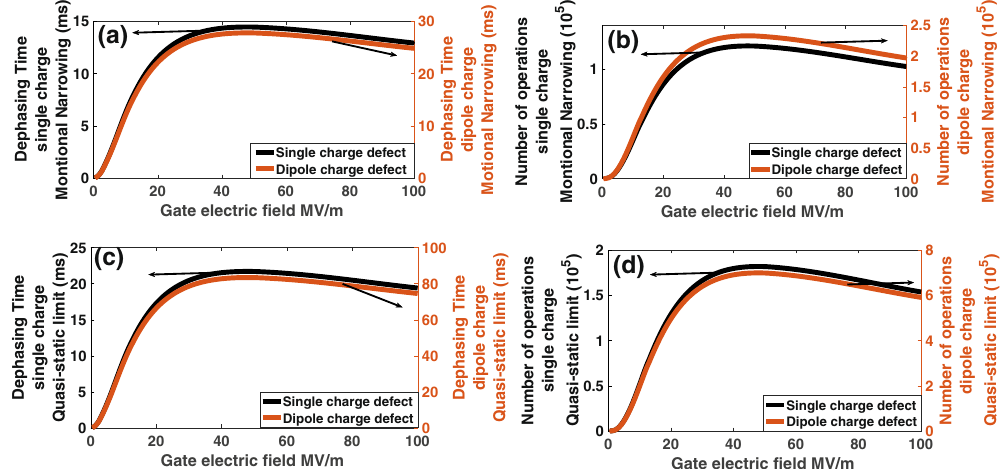
Fig. 3 Dephasing time. In all plots, the quantum well width is d = 11 nm and dot radius a 0 = 50 nm. a Dephasing time in the motional narrowing regime. b The allowable number of single-qubit operations in one dephasing time in motional narrowing regime. c Dephasing time in the quasi-static limit. d The allowable number of single-qubit operations in one dephasing time in the quasi-static